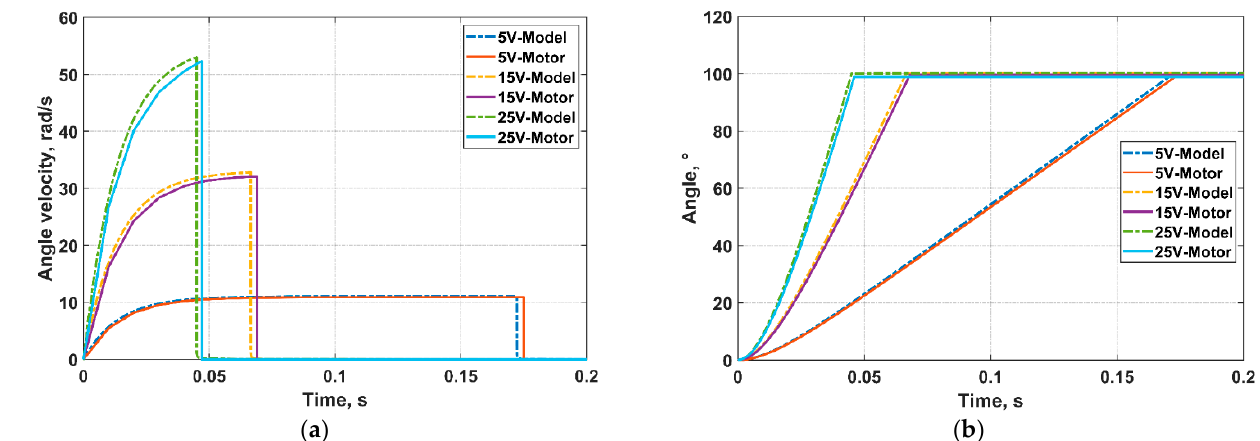
Figure 3. Comparison results between motor and physical model. ( a ) Angle velocity. ( b ) Angle.